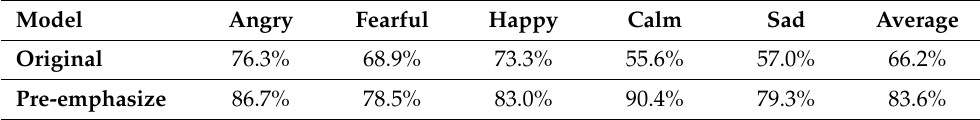
Table 1. Comparison of original method and pre-emphasized